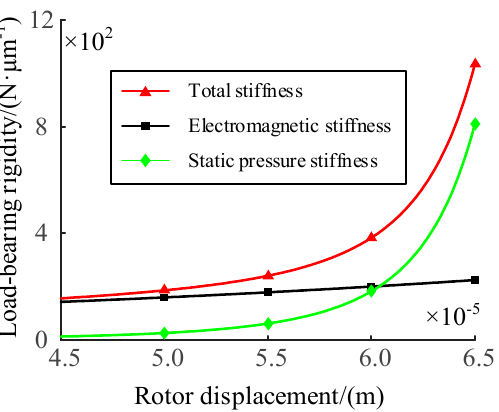
Figure 5. Relation curve between bearing stiffness and displacement Δ x .